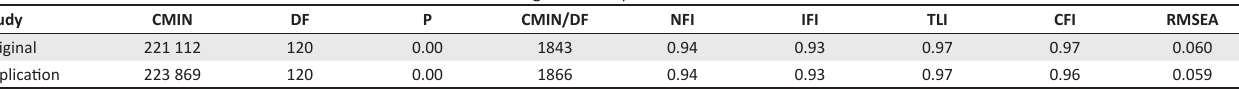
TABLE 3: Goodness-of-fit measures of the measurement model in the original and replication studies.